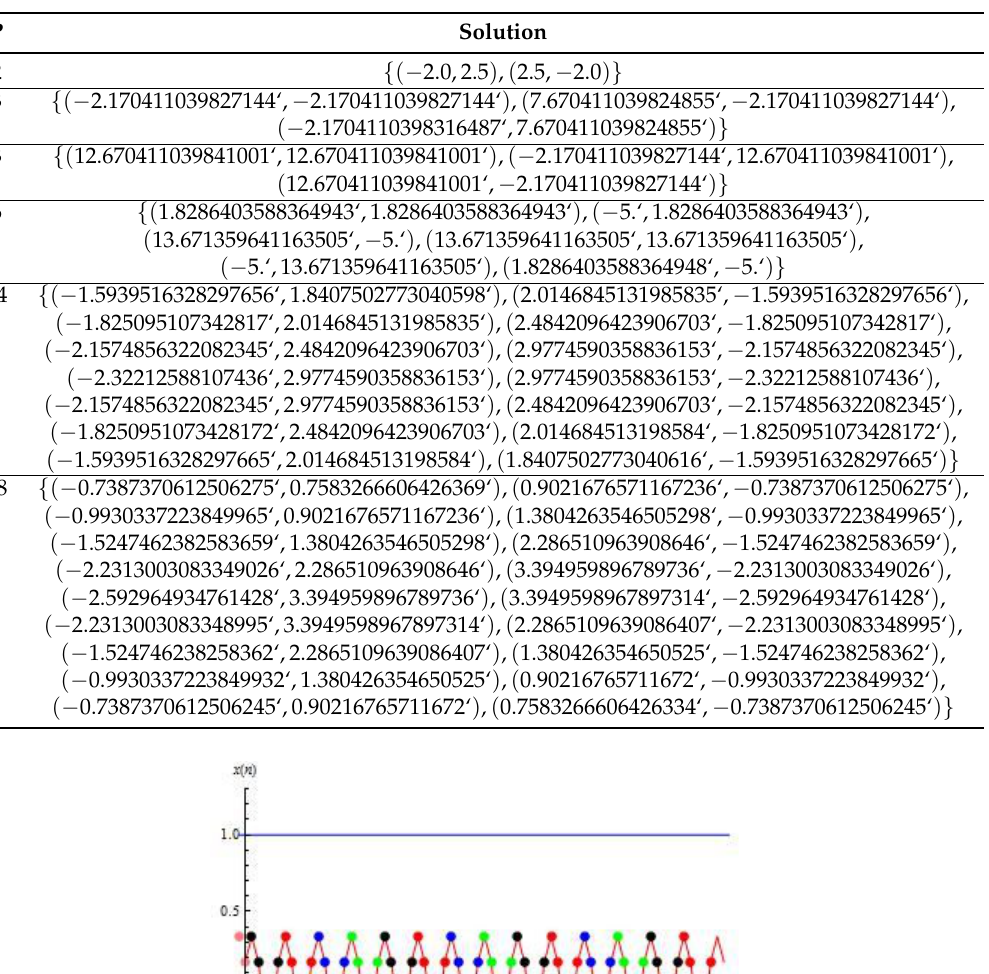
Table 2. List of periodical solutions of the period 2,3,6,14 and 18 for α = − 2.1, β = 0.2.